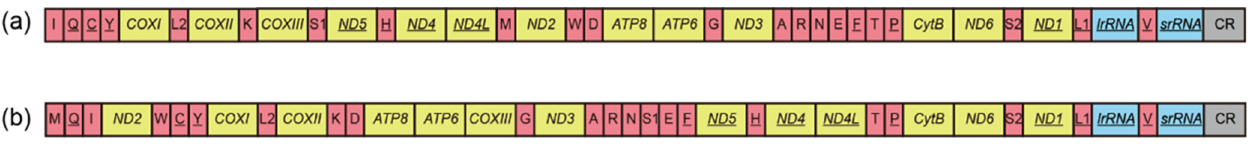
Figure 4. The mitochondrial gene order of the genera Potamyia and Arctopsyche . Genes are transcribed from left to right except those underlined, which have the opposite transcriptional orientation. Protein-coding genes are indicated in yellow, tRNA in red, rRNA genes in blue, and control regions in gray: ( a ) Potamyia chinensis and Potamyia horvati ; ( b ) Arctopsyche spinescens and Arctopsyche sp.